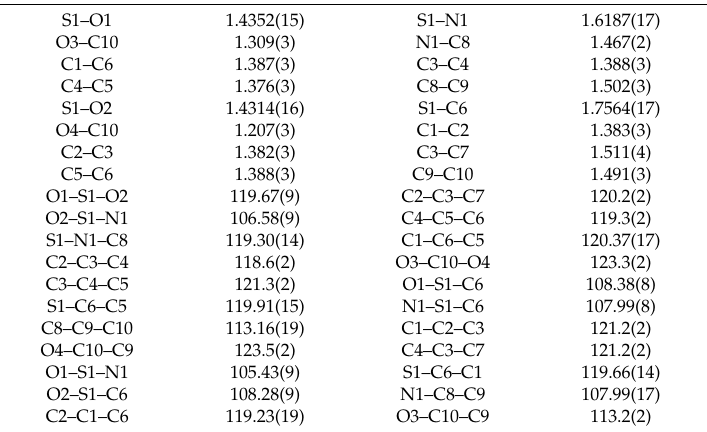
Table 2. Bond lengths (Å) and angles ( ◦ ) for 4b .